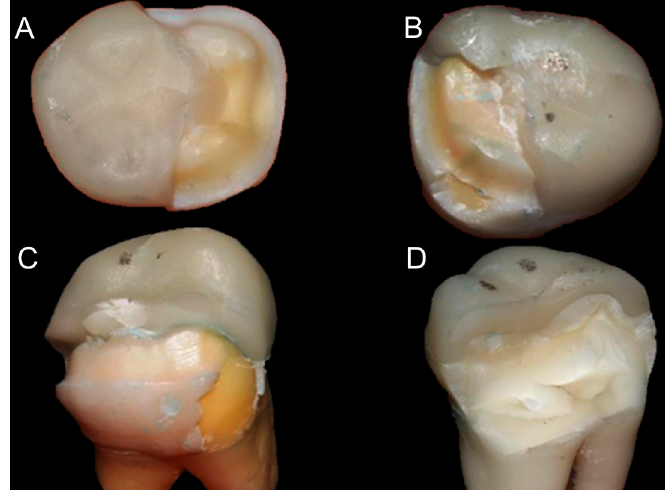
Figure 2- Types of fracture. (A) Type 1, Fractures involving a small portion of the coronal tooth structure; (B) Type 2, fractures involving a small portion of the coronal tooth structure and cohesive failure of the restoration; (C) Type 3, fractures involving the tooth structure, cohesive and/or adhesive failure of the restoration, and root involvement that can be restored in association with periodontal surgery; and (D) Type 4, severe root and crown fracture, necessitating extraction of the